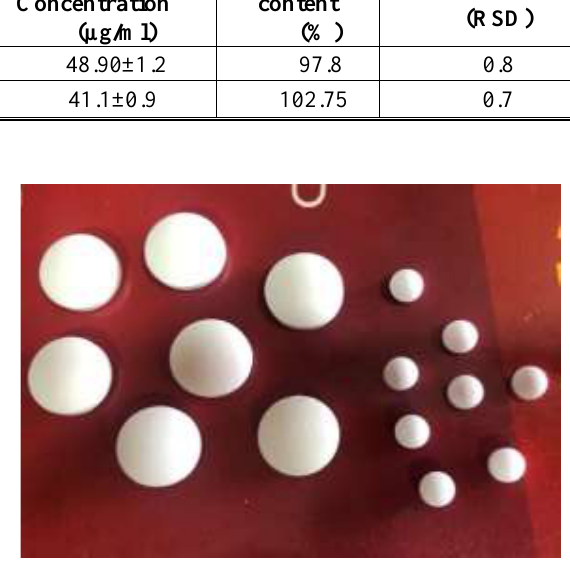
Figure 3.The coated tablets and the